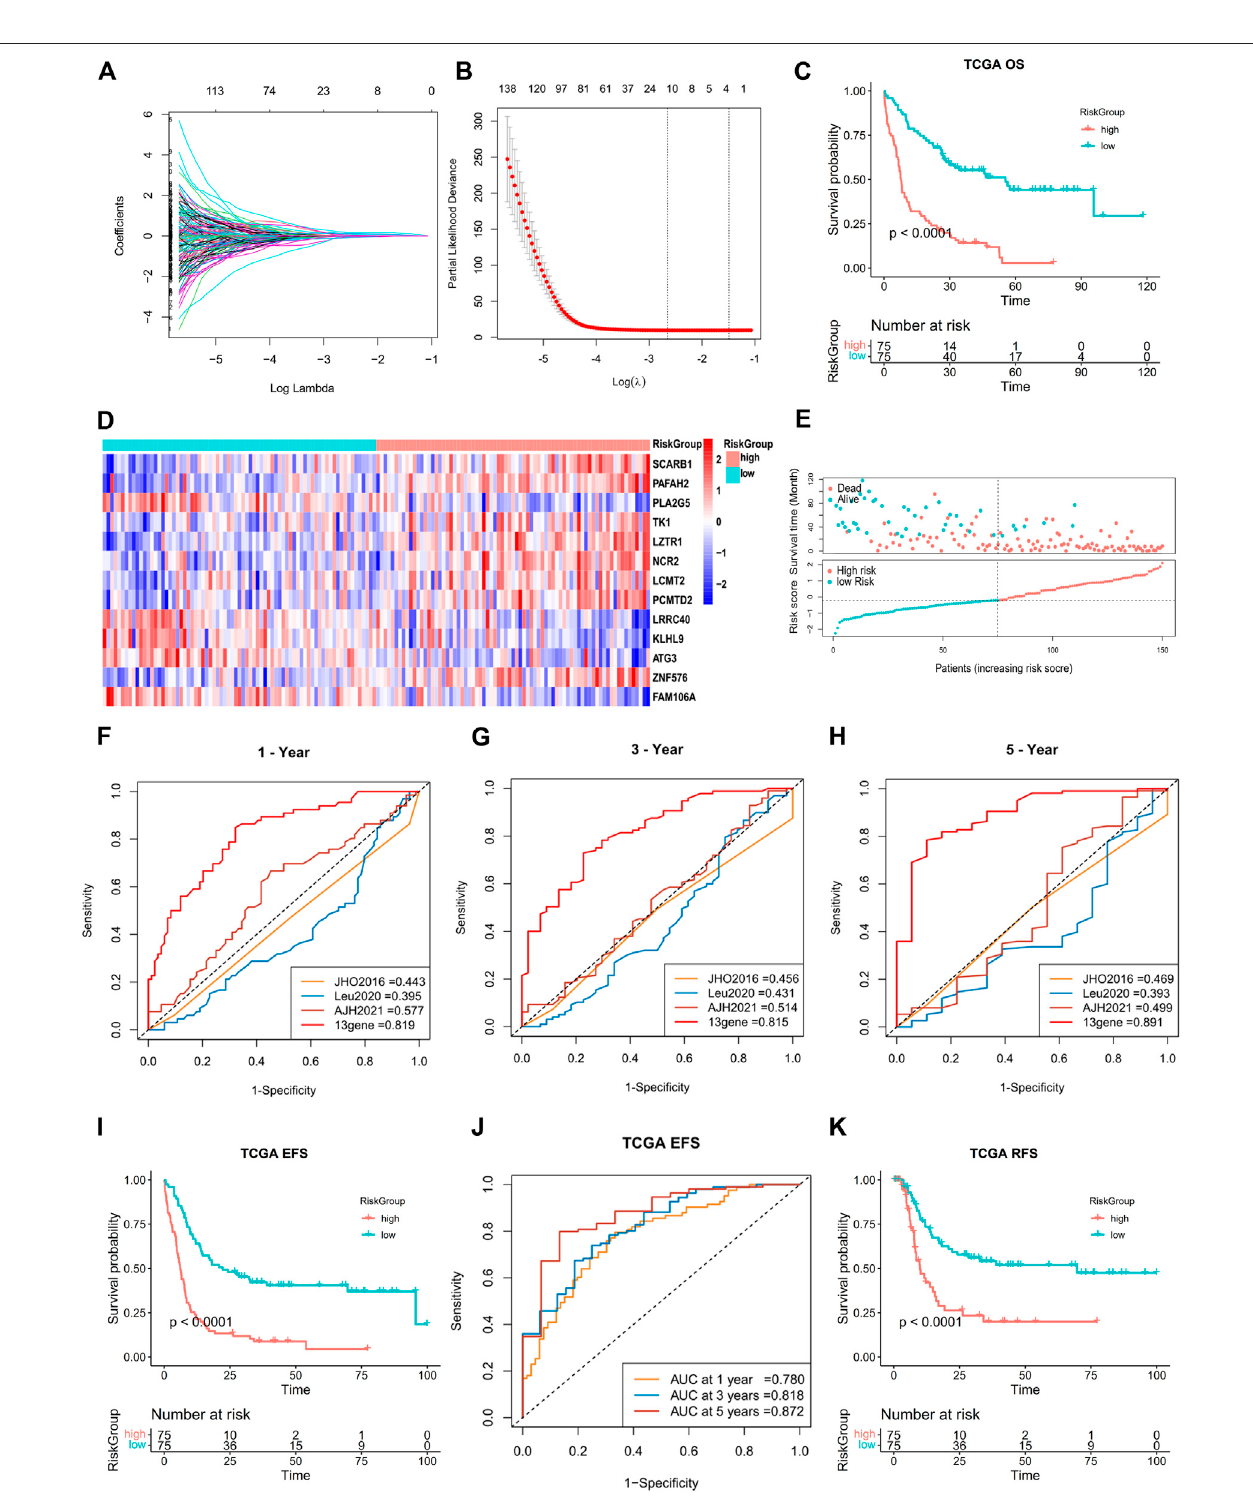
FIGURE 4 | Construction of a 13-gene prognostic signature by DEGs in two subtypes. (A , B) Least absolute shrinkage and selection operator (LASSO) regression analysis with ten-fold cross validation to determine the lambda number. (C) OS analysis of the risk group in TCGA dataset (log-rank p-test). (D) Heatmap of 13-gene expression in different risk groups (Wilcoxon tests). (E) Dot plot showing the distribution of risk score in patients with different survival time and status in TCGA. (F – H) Prognostic ROC AUC comparison in the 13-gene signatures with other known signatures in the training datasets (TCGA) for 1, 3, and 5 years. (I , J) EFS analysis and ROC of the risk group in TCGA dataset (log-rank p -test). (K) OS analysis of the risk group in the GSE10358 dataset (log-rank p -test).